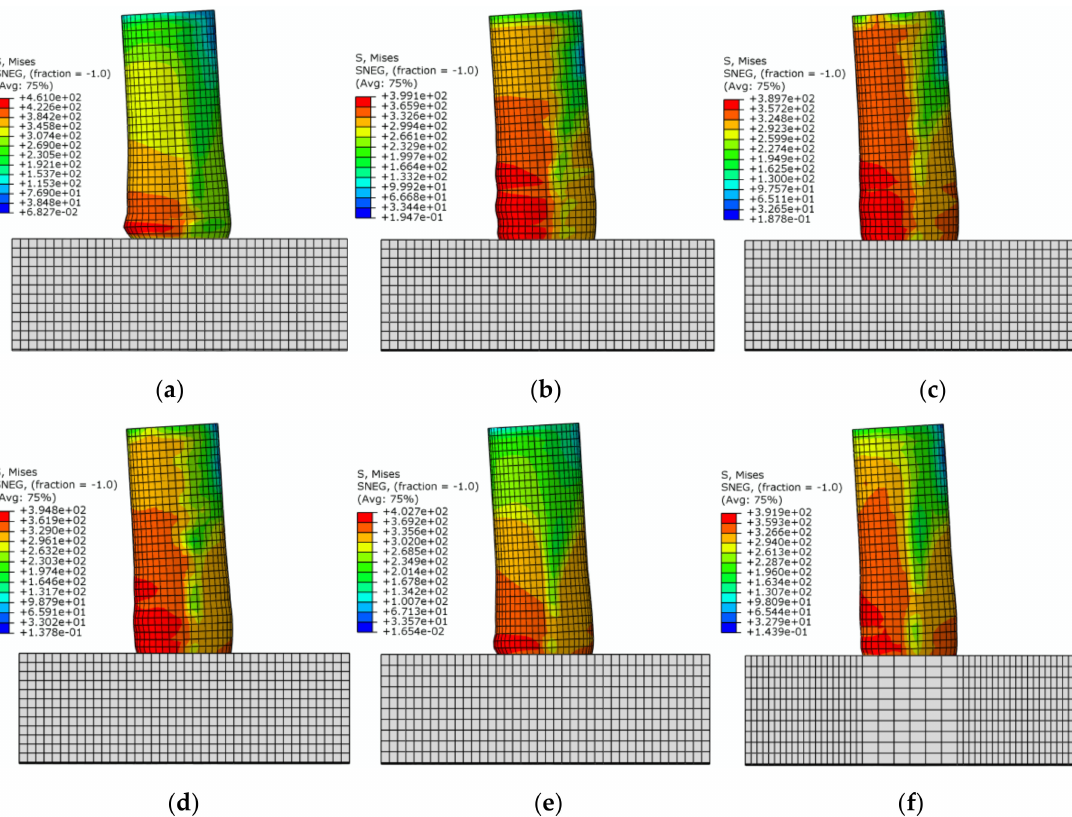
Figure 18. Mises stress conctour plot of outer steel tube. ( a ) CFST-N; ( b ) CFST-HS; ( c ) CFST-VS; ( d ) CFST-SR; ( e ) CFST-DT; and ( f )